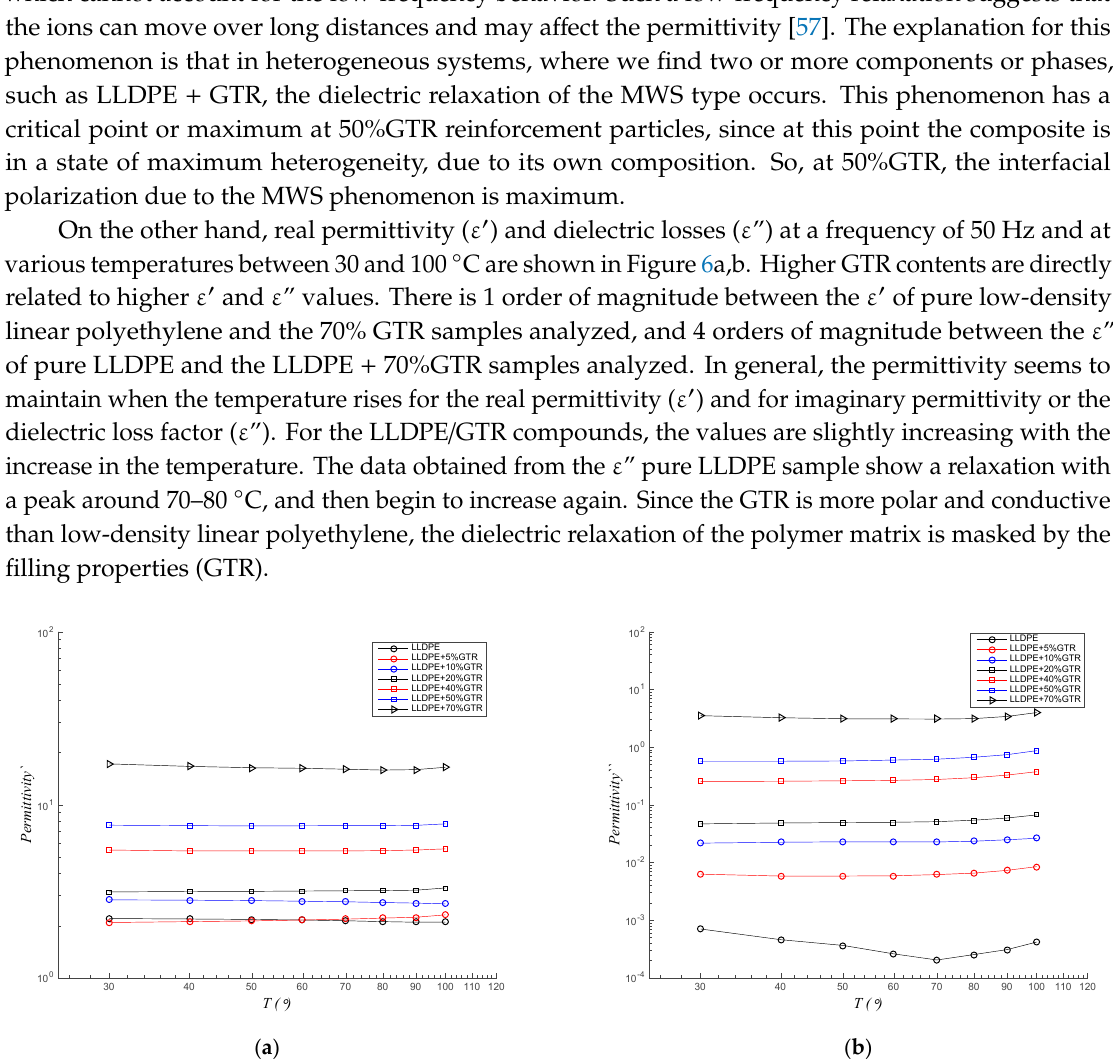
Figure 5. Compounds LLDPE/GTR, at 30 °C in relation to frequency (From 10 − 2 to 3·× 10 6 Hz). ( a ) Real permittivity, ε ’, and ( b ) dielectric losses factor, ε ’’.